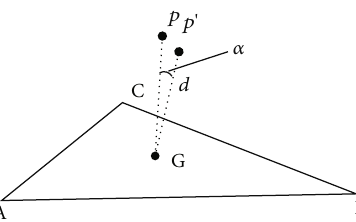
Figure 3: Correction diagram of the displacement between the point to be interpolated and projection